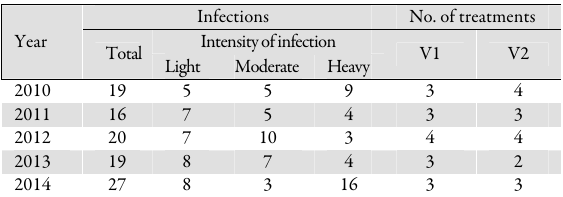
Table 1. Infections of B. jaapii (cherry leaf spot) and treatments against it during 2010-2014 Infections Year